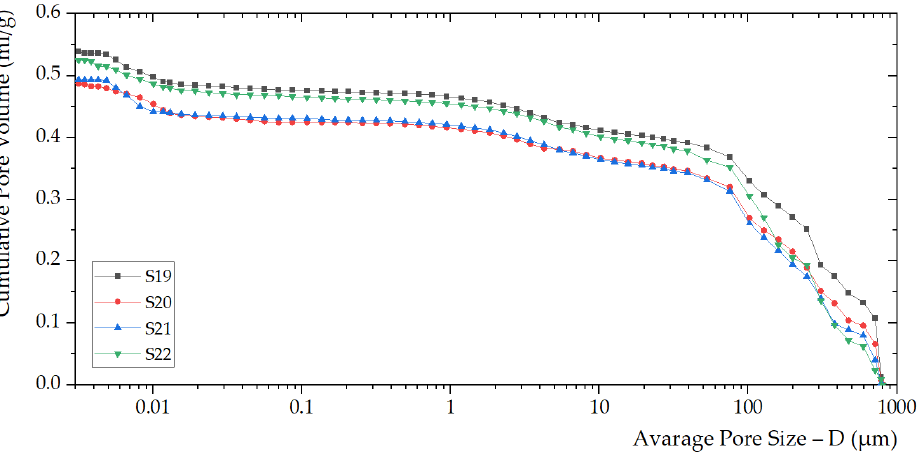
Figure 5. Curves of S19, S20, S21, and S22 illustrate the average pore size (D) versus cumulative pore volume.